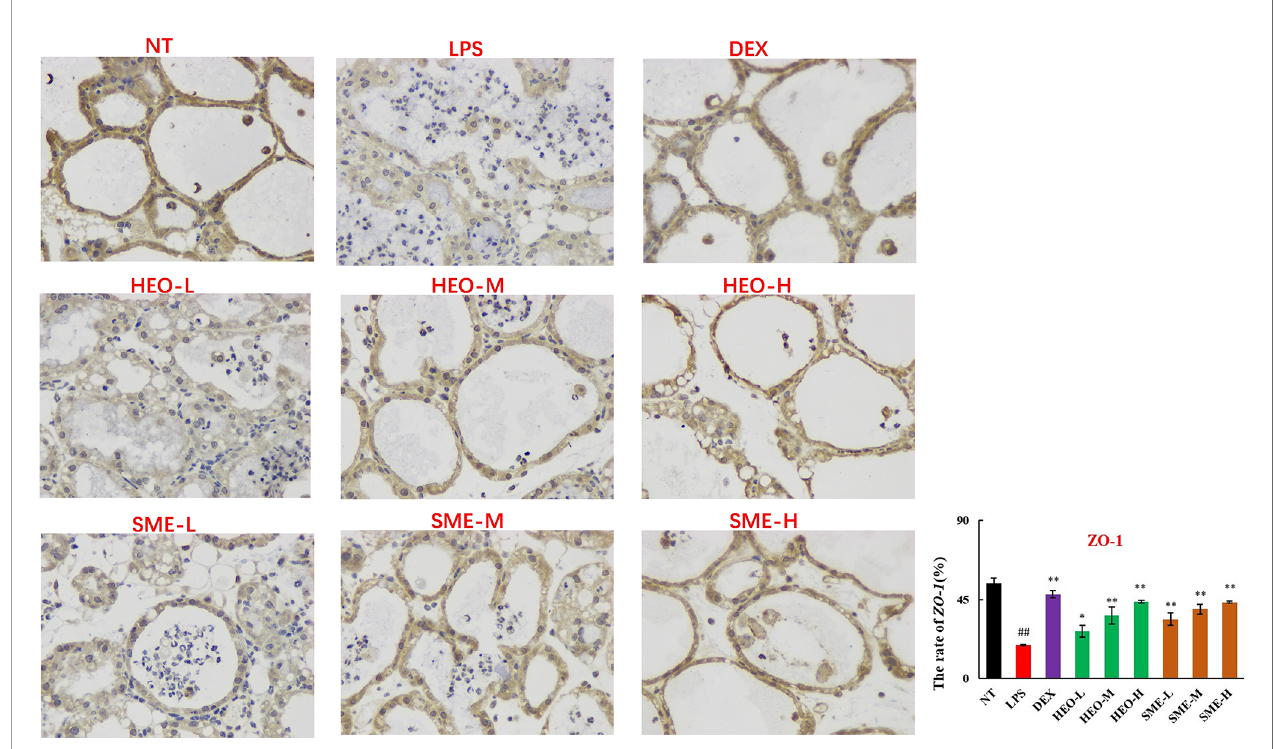
FIGURE 7 | Distribution and expression of connexin ZO-1 in LPS-induced murine mastitis, indicated by brown or yellow colors. Mean ± SD, n = 6. ## P < 0.01 compared to blank group; * P < 0.05, ** P < 0.01 compared to model